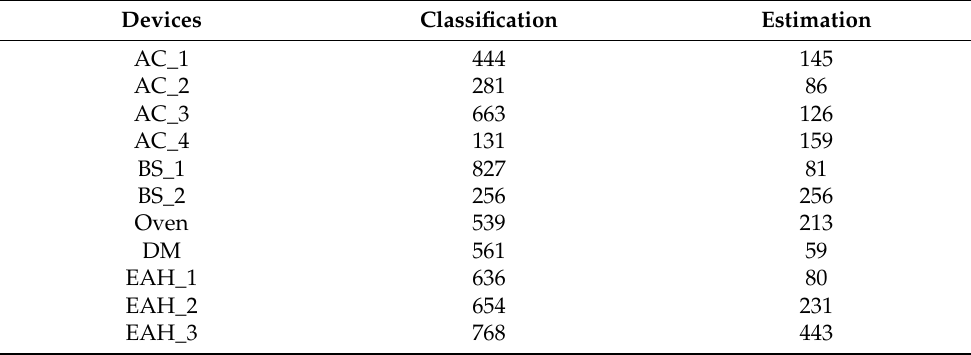
Table 22. Dimensions of non-dominated